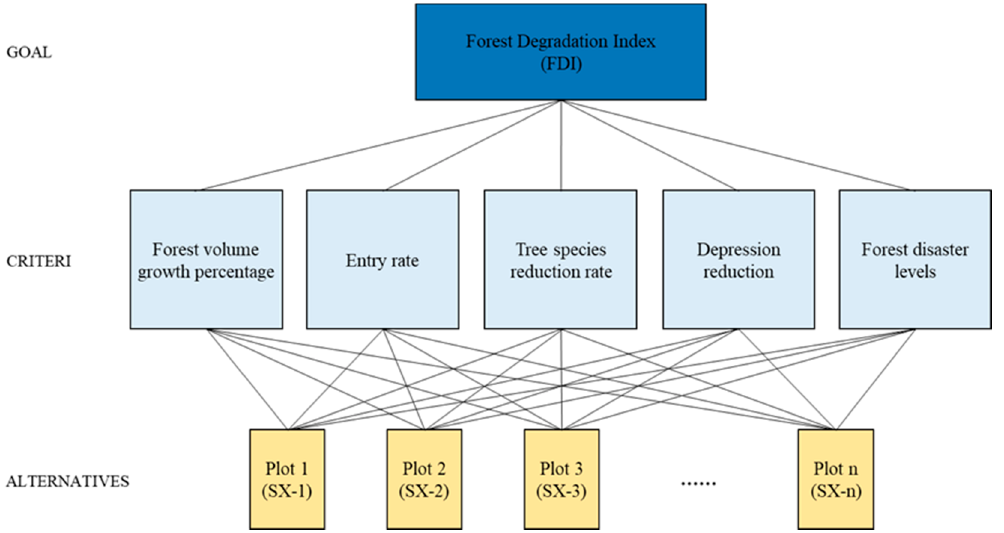
Figure 2. The forest degradation index (FDI) is divided into two hierarchical structures (Modica et al. [19] after modifications). SX includes Site A (SA), Site B (SB), Site C (SC) and Site D (SD). SA is broad-leaved mixed forest and SB is eucalyptus forest in Guangdong province; SC is spruce forest and SD is fir forest in Tibet autonomous region.